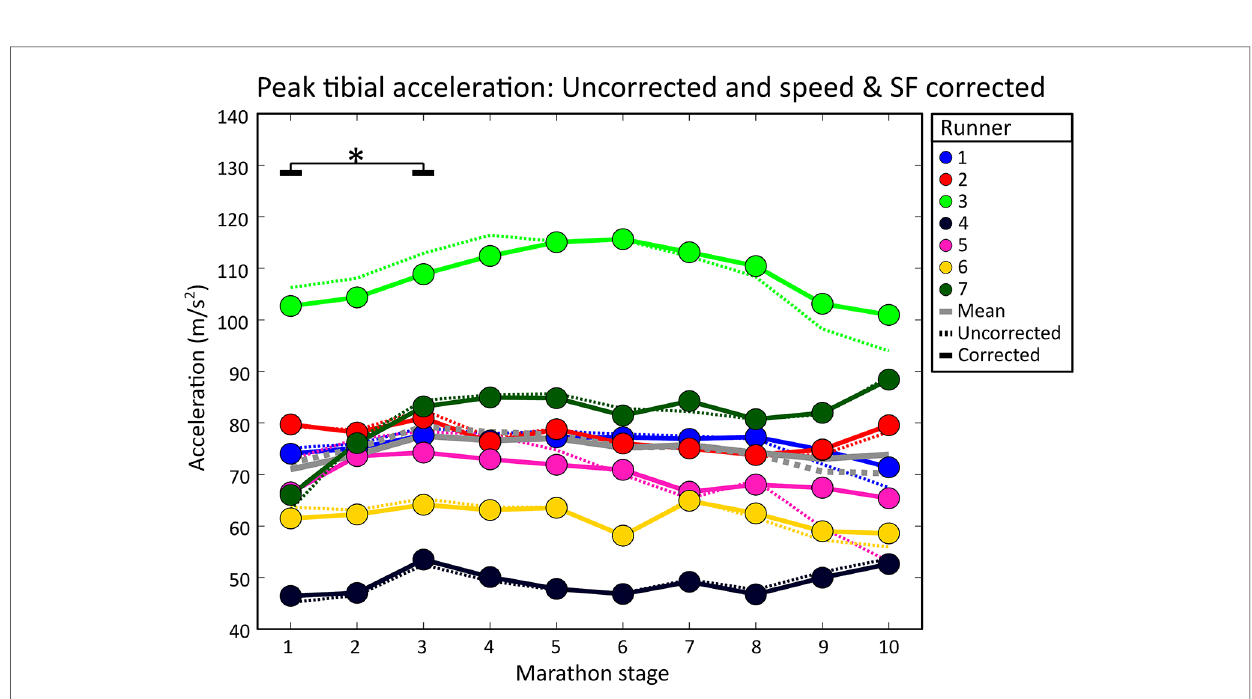
FIGURE 5 Individual mean peak tibial accelerations during all marathon stages. Dotted lines show uncorrected PTA values (i.e., as measured during the marathon). Solid lines represent speed and stride frequency corrected PTA values. Grey lines show the group means. Signi fi cant effects of running duration are shown with an asterisk and black lines. Solid black lines represent signi fi cant differences in corrected PTA